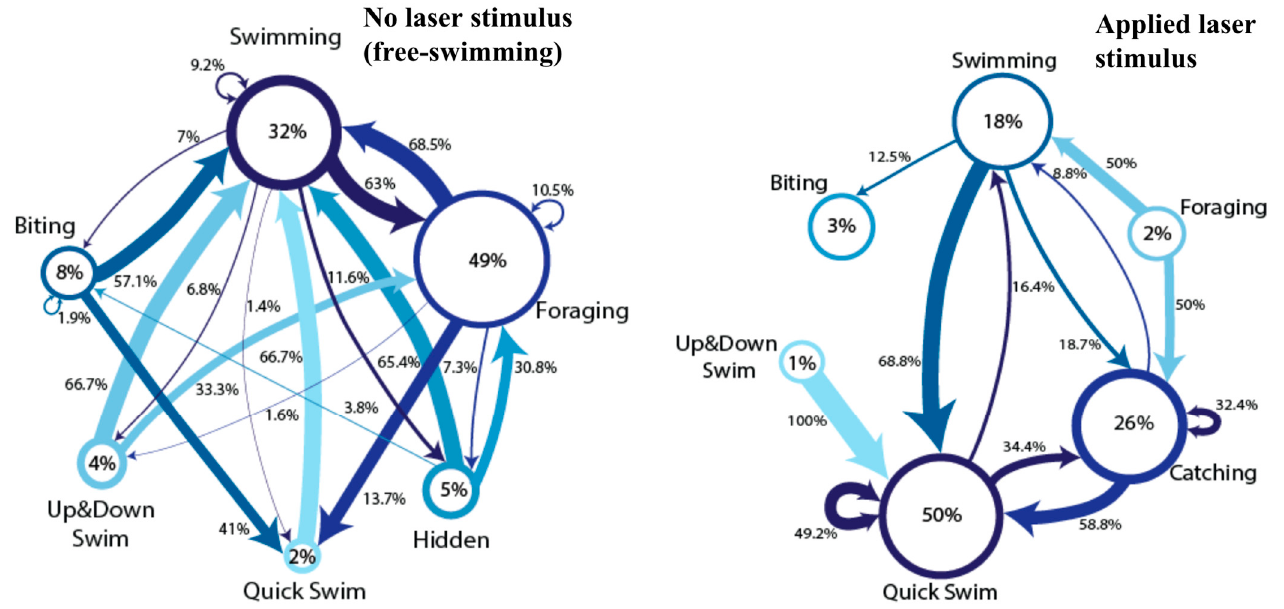
Figure 2. Comparative ethograms of a white-spotted cichlid fish with ( left ) and without ( right ) presentation of red laser stimulus. Diameter of circles corresponds to how much time was spent performing each behavior, and thicknesses of arrows correspond to the likelihood that one behavior would proceed another. The shading ranges from darkest (most time spent performing behavior) to lightest (least time spent). Numerical percentages of time spent in behavior states and transition likelihoods are within circles and beside arrows. Free-swimming ethogram data totaled 10 hours of observation, and laser stimulus ethogram observation time totaled 10 minutes.